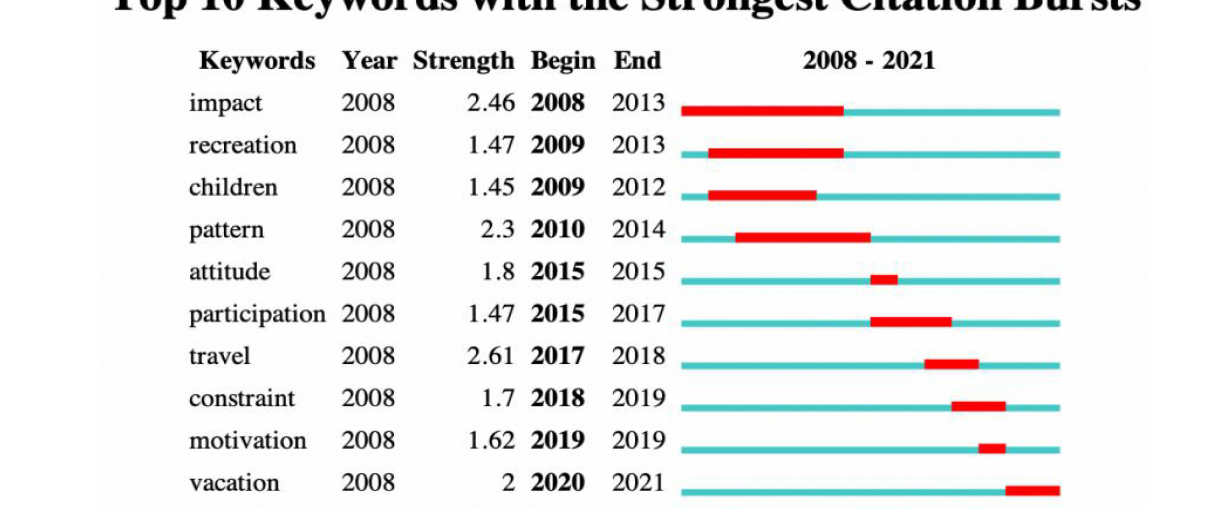
FIGURE 5 | Top 10 keywords with the strongest citation bursts.